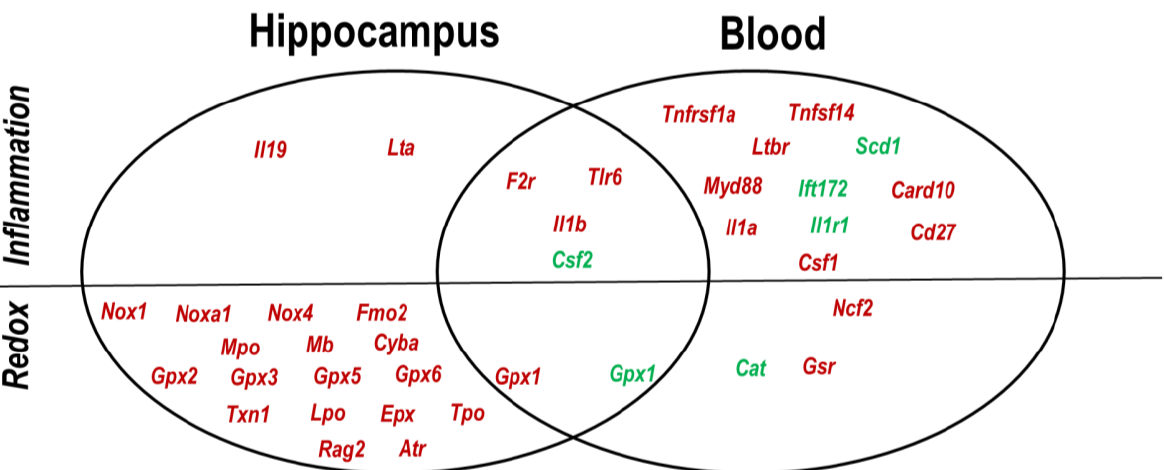
Figure 4. Inflammation and redox-related genes differentially and commonly expressed in the hip- pocampus and in the whole blood of AT mice vs. WT controls. Only genes with |FR| > 1.8 and p < 0.05 are reported. Red font indicates up-regulated and green font down-regulated genes.